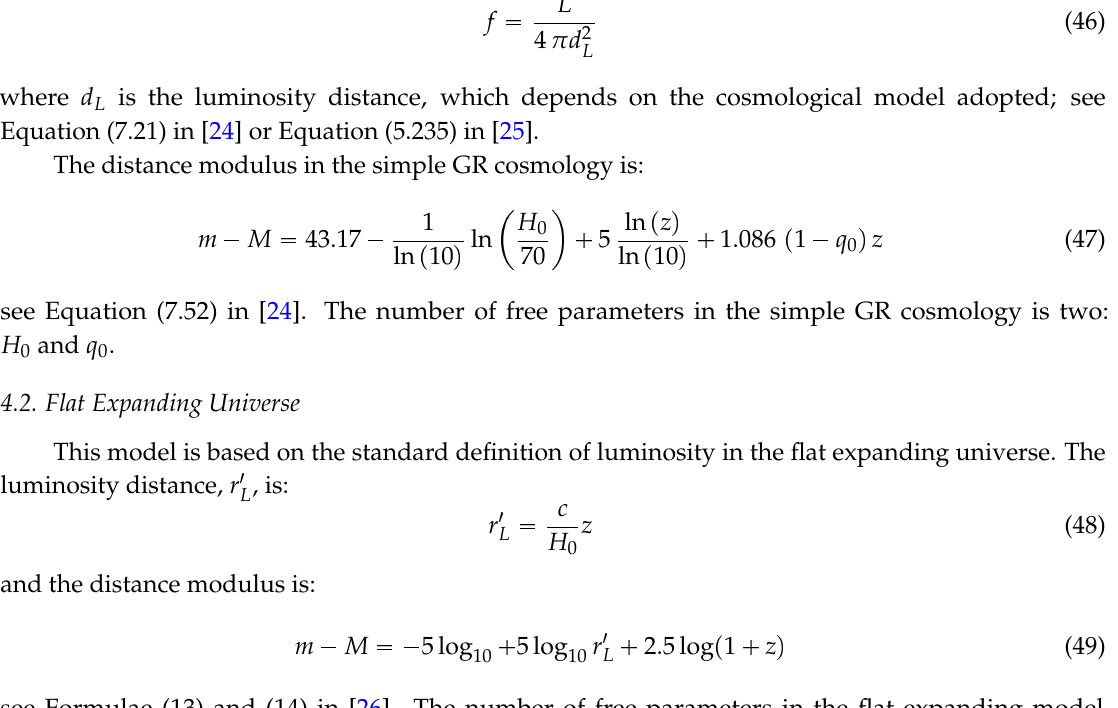
0.6 and ∆ z 0.05. Parameters (cid:16) (cid:16)